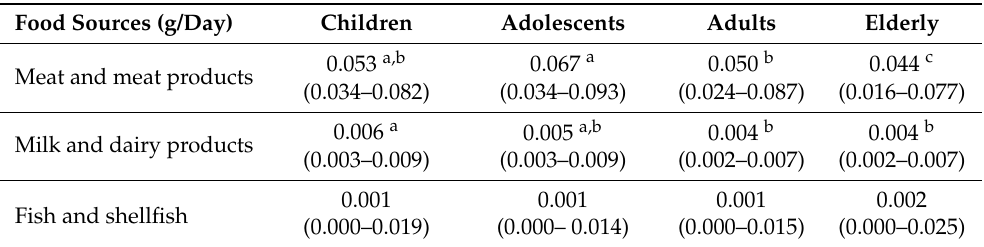
Table 20. Contribution of dietary food sources to arachidonic acid (AA) intakes per age group among the ANIBES Study